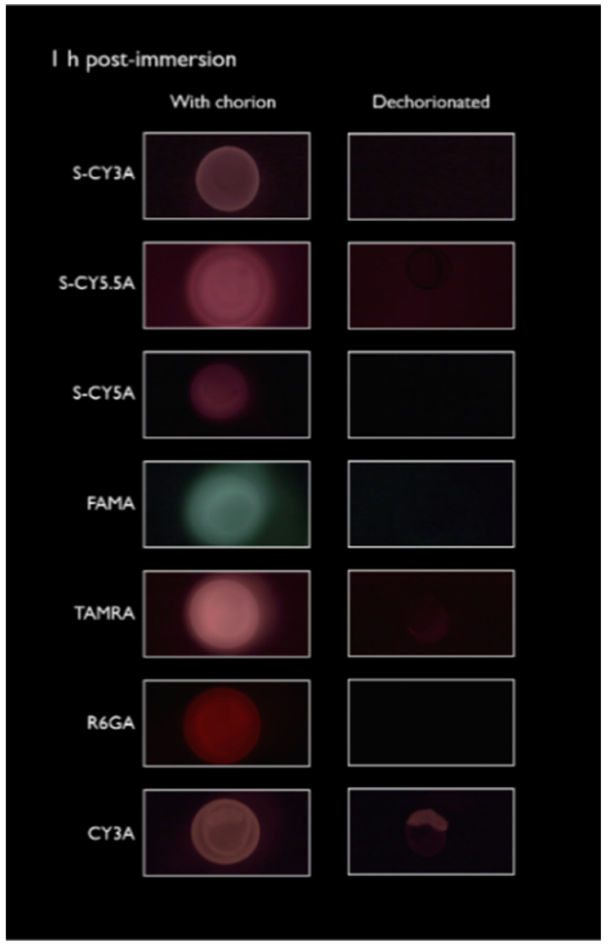
Figure 1. Representative fluorescent images of embryos exposed to the different fluorescent com- pounds by immersion (10 µ M) for 1 h, before (left panel) and after dechorionation and rinsing (right